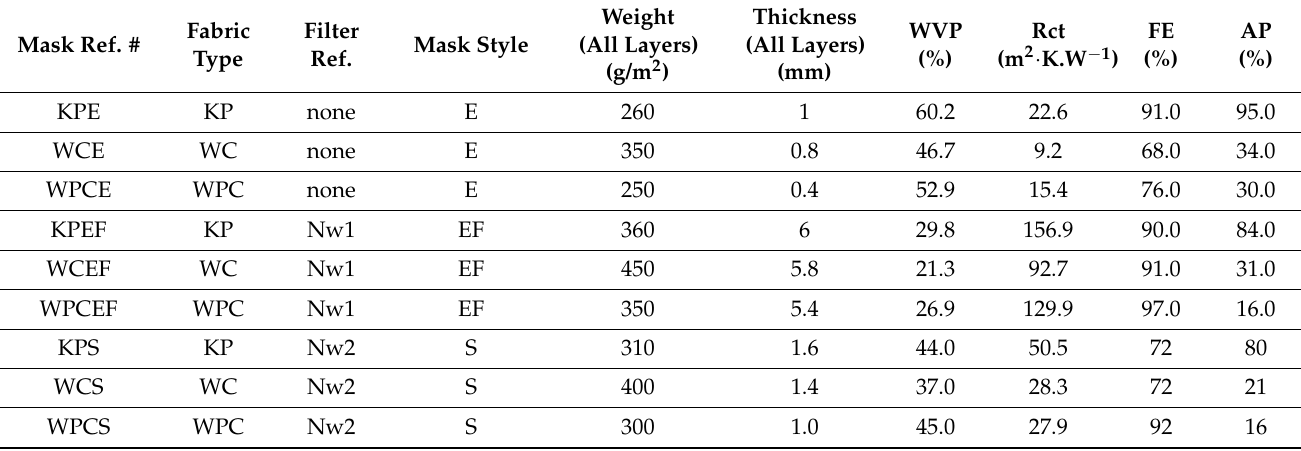
Table 1. Referencing and description of structural and performance properties of fabric layer combi- nations resembling those in the masks selected for this study.